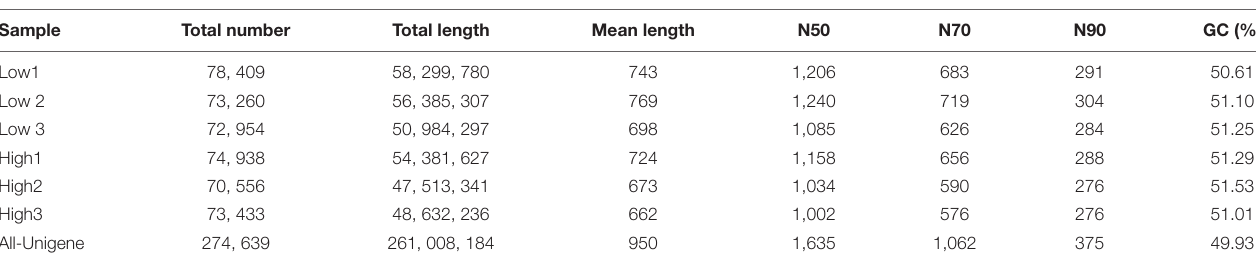
TABLE 2 | Trinity